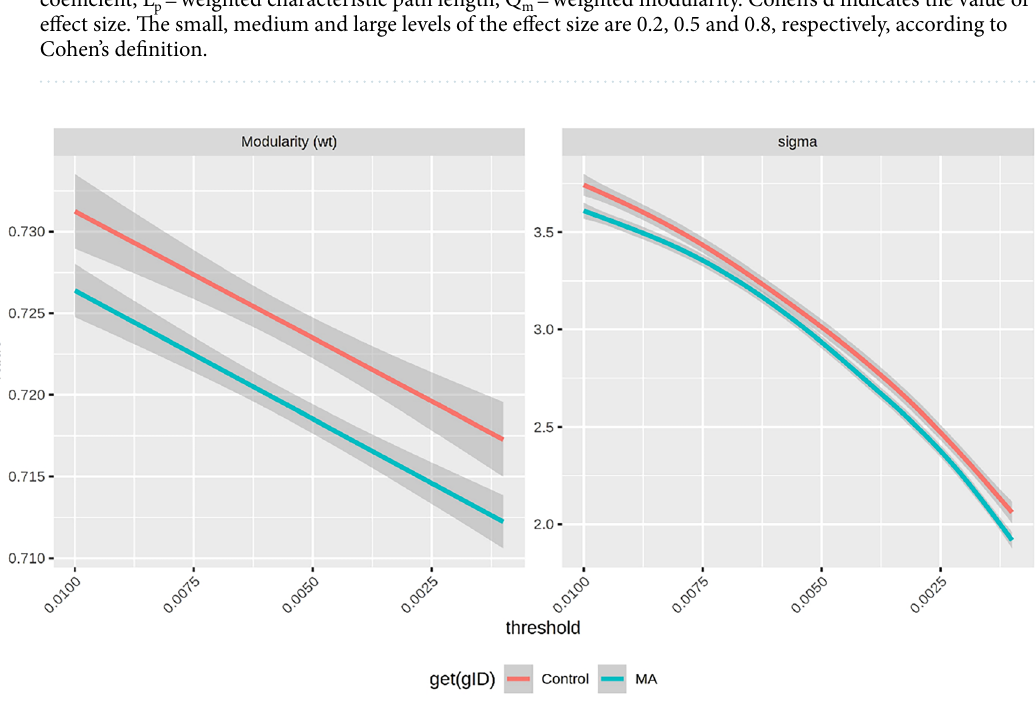
Figure 1. Network modularity and small-worldness (σ) in control and MA groups at each threshold. MA: methamphetamine-dependent patients; control: healthy